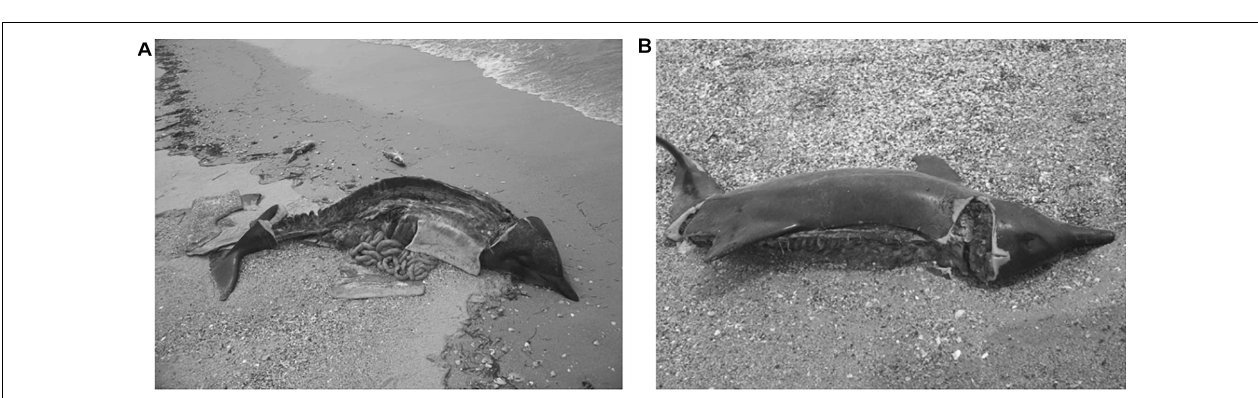
FIGURE 2 | Answers to the following questions in each locality evaluated and the total: (A) What kind of animal is it? (B) Has a tonina ever been caught in a net during your fishing operations? (C) How often do you think that happens in this locality? (D) What is the most frequent size of the tonina you caught?